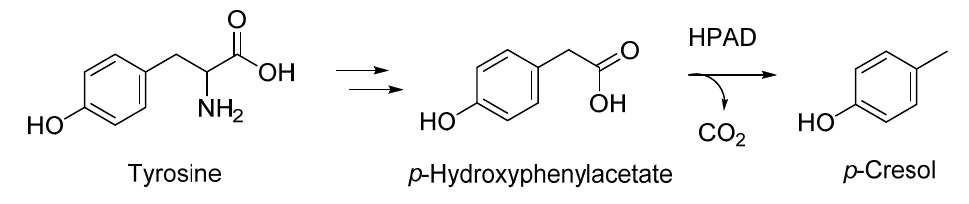
Figure 4. Formation of p -cresol by anaerobic-fermenting bacteria. HPAD: p -hydroxyphenylacetate decarboxylase.